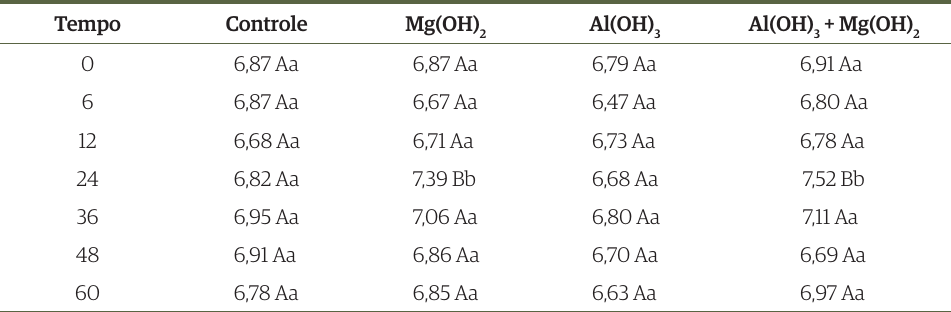
tabela 1. Valores médios de pH fecal, nos diferentes tratamentos: Grupo controle, Mg(OH) Mg(OH) + Al(OH) . 2 3